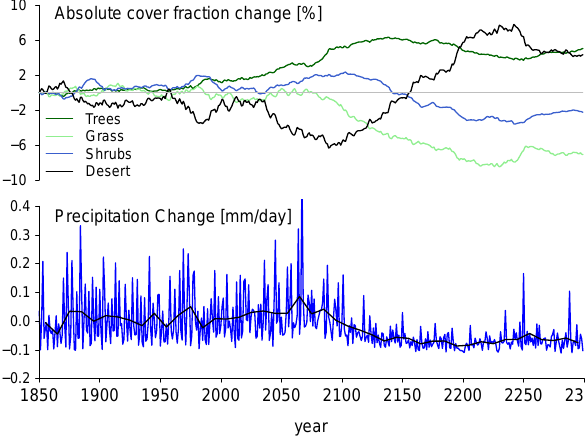
Fig. 7. Time series of differences in vegetation cover (top figure) in the Sahara/Sahel region (20 ◦ W–45 ◦ E and 10 ◦ N–35 ◦ N). The bottom figure shows the differences in annual mean precipitation over land (blue) and the differences in 10yr mean precipitation over land (black) due to anthropogenic climate change and vegetation cover change (DYN –